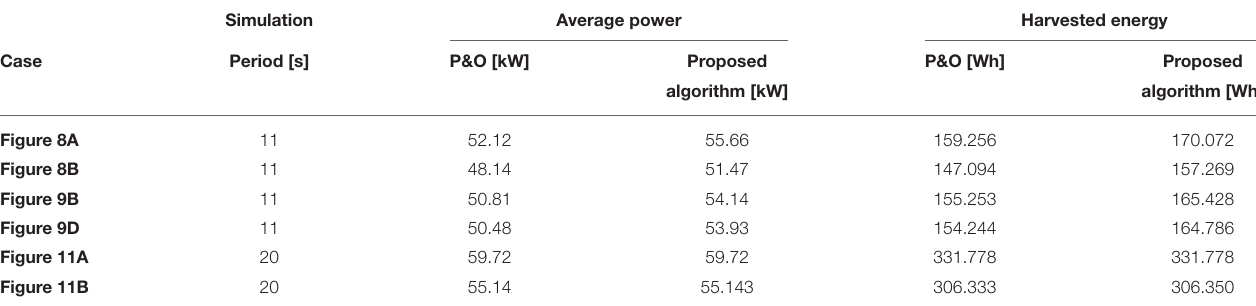
TABLE 2 | Average power and harvested energy from PV system under considered conditions using P&O and proposed algorithm.